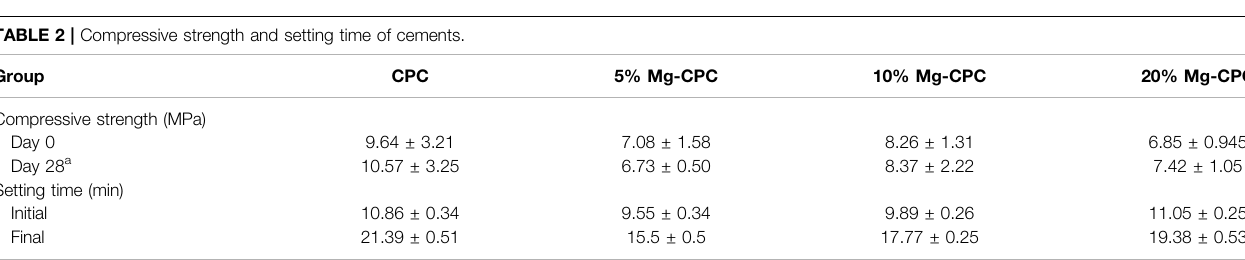
TABLE 2 | Compressive strength and setting time of